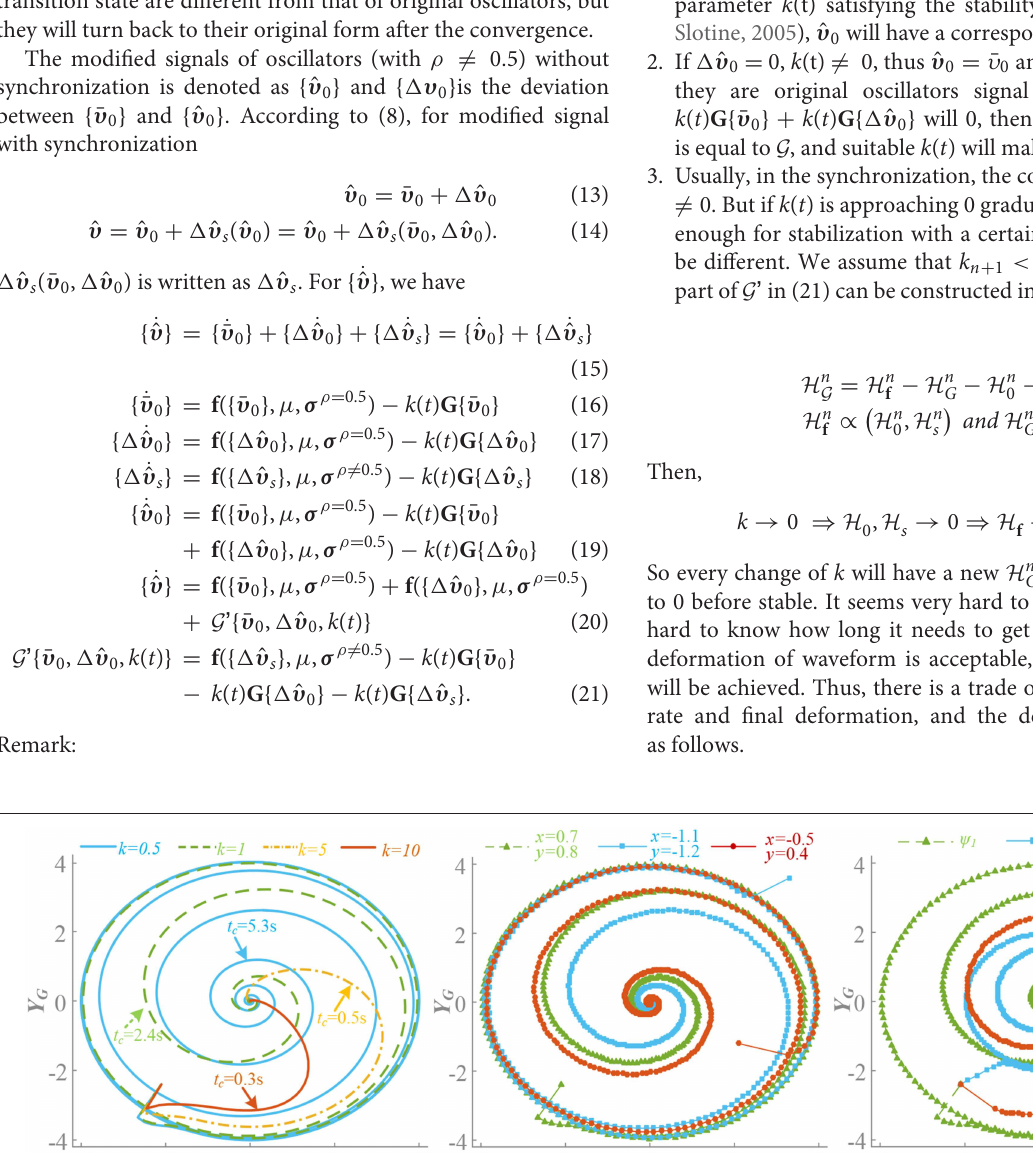
Frontiers in Neurorobotics |